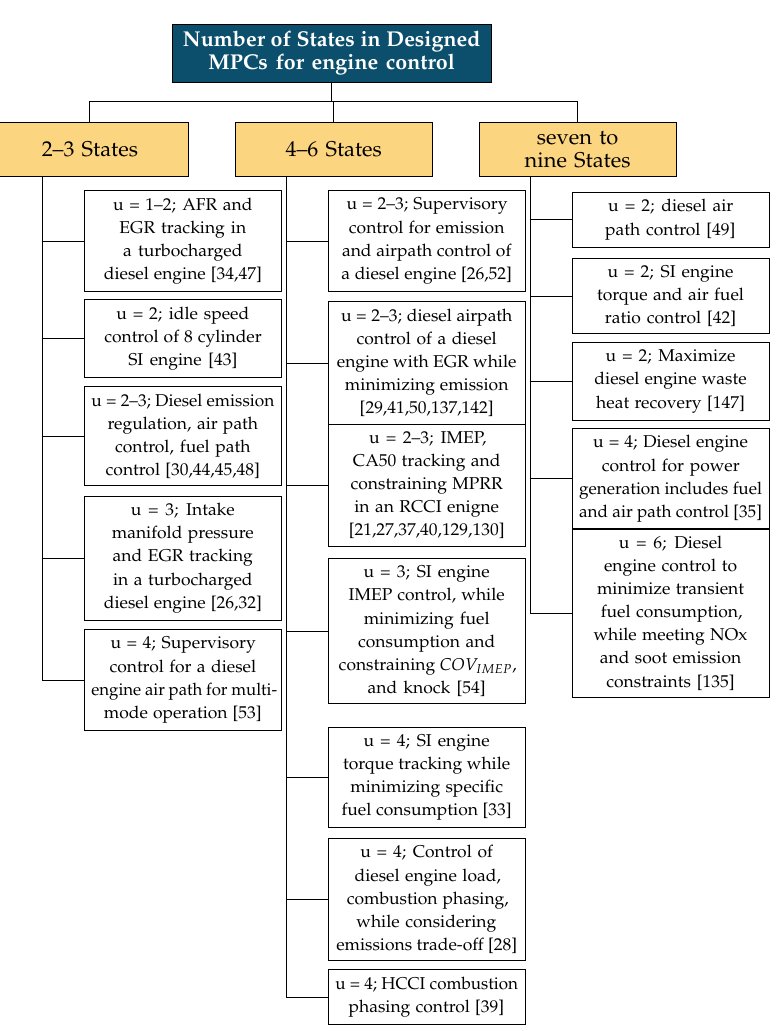
Figure 10. Number of states (x) and inputs (u) for demonstrated MPC applications on